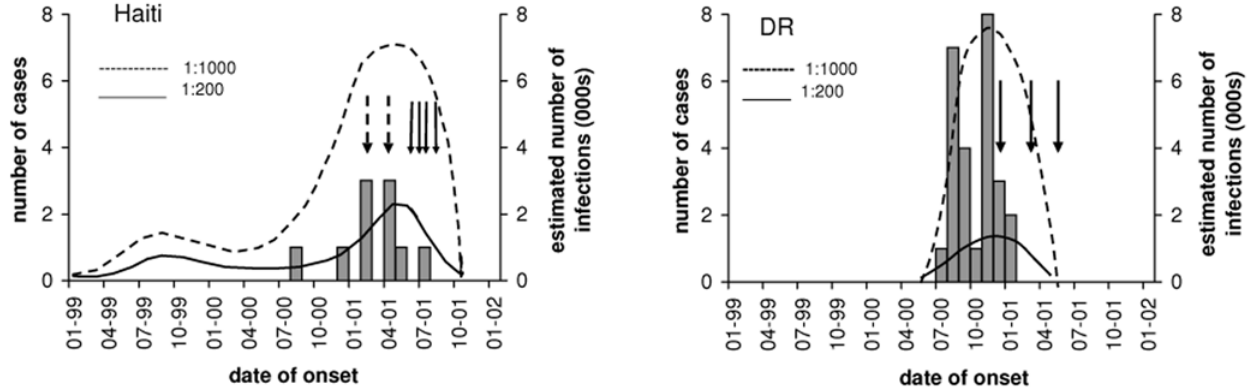
Figure 2 . (adaptedfromFig1;Kewetal.2002Science296:356:359) Temporal distribution of virologically-confirmed and compatible cVDPV cases (grey bars) in Haiti (left hand panel) and in the DR (right hand panel), plotted against the left axis. The estimated number of infections (dotted lines) between the estimated date of the initiating infection and the end of the outbreak is shown against the right hand axis. The number and temporal distribution of these infections represents our best estimate, assuming infection peaks during the summer months, average case ascertainment of 20% in Haiti, and 50% in the DR, and constant case to infection ratios of 1:200 (----) or 1:1000 (- - -). Black arrows indicate the dates of NIDs, dashed arrows represent sub-optimal NIDs (in Haiti), and the smaller arrows represent the rolling immunisation campaign in Haiti between May and July 2001.